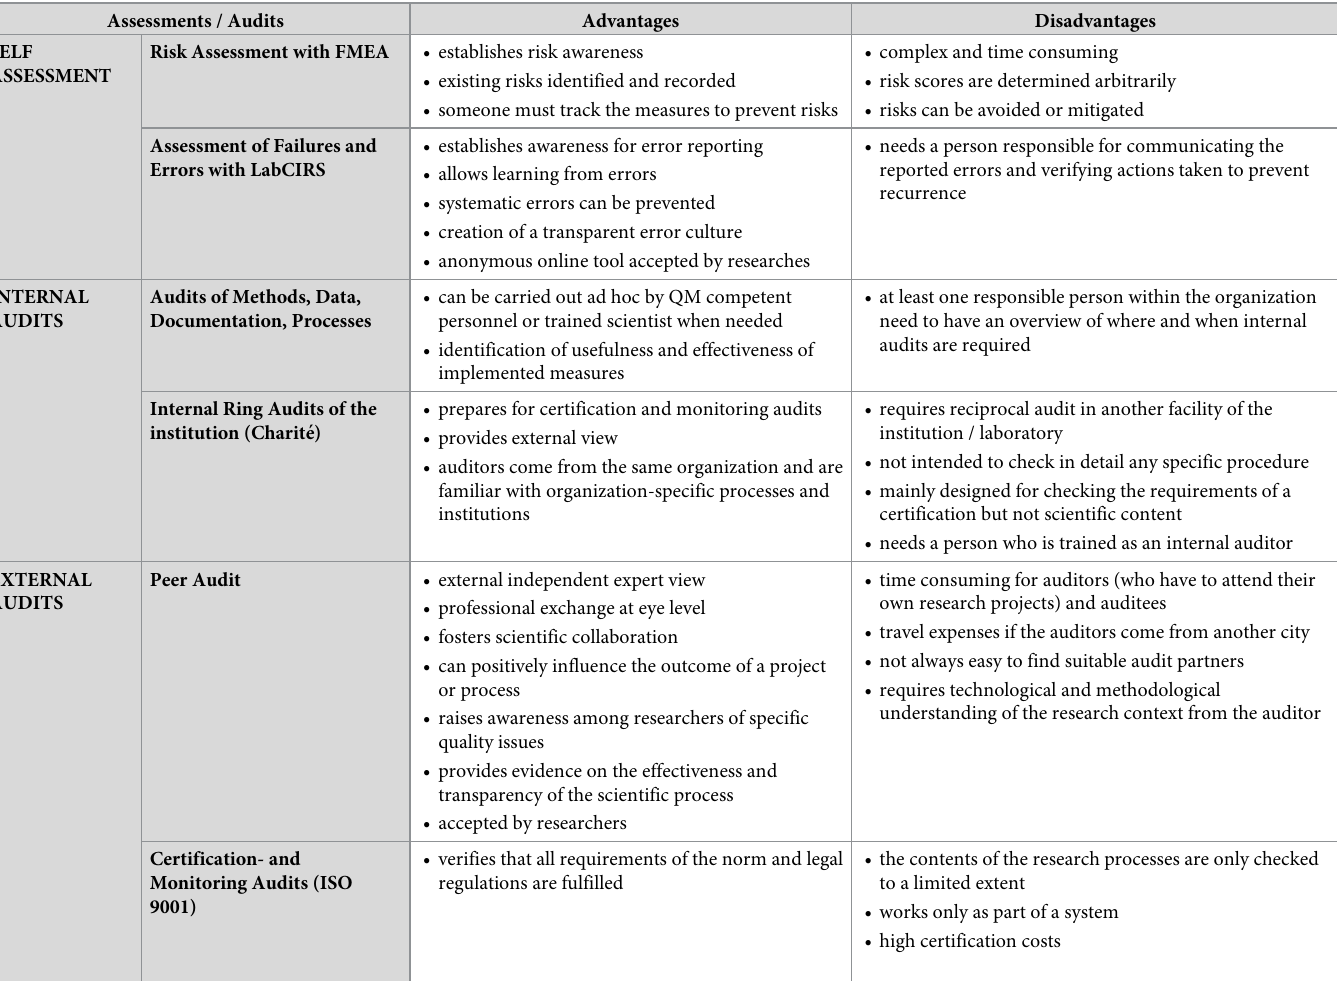
Table 4. Results of audits and assessments performed in the Department of Experimental